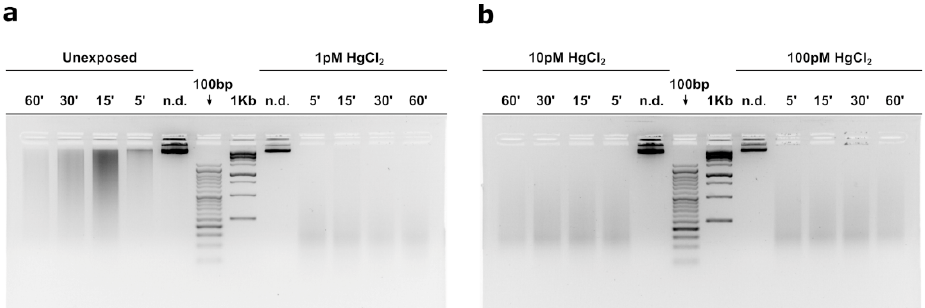
Figure 5. Micrococcal nuclease (MNase) digestion time course of Mytilus galloprovincialis ’ sperm chromatin. Analyses of DNA by electrophoresis on agarose gel: unexposed and exposed mussels to 1 pM HgCl 2 (Panel ( a )), exposed mussels to 10 and 100 pM HgCl 2 (Panel ( b )). n.d. = undigested sperm genomic DNA. 1Kb and 100 bp: molecular weight markers.